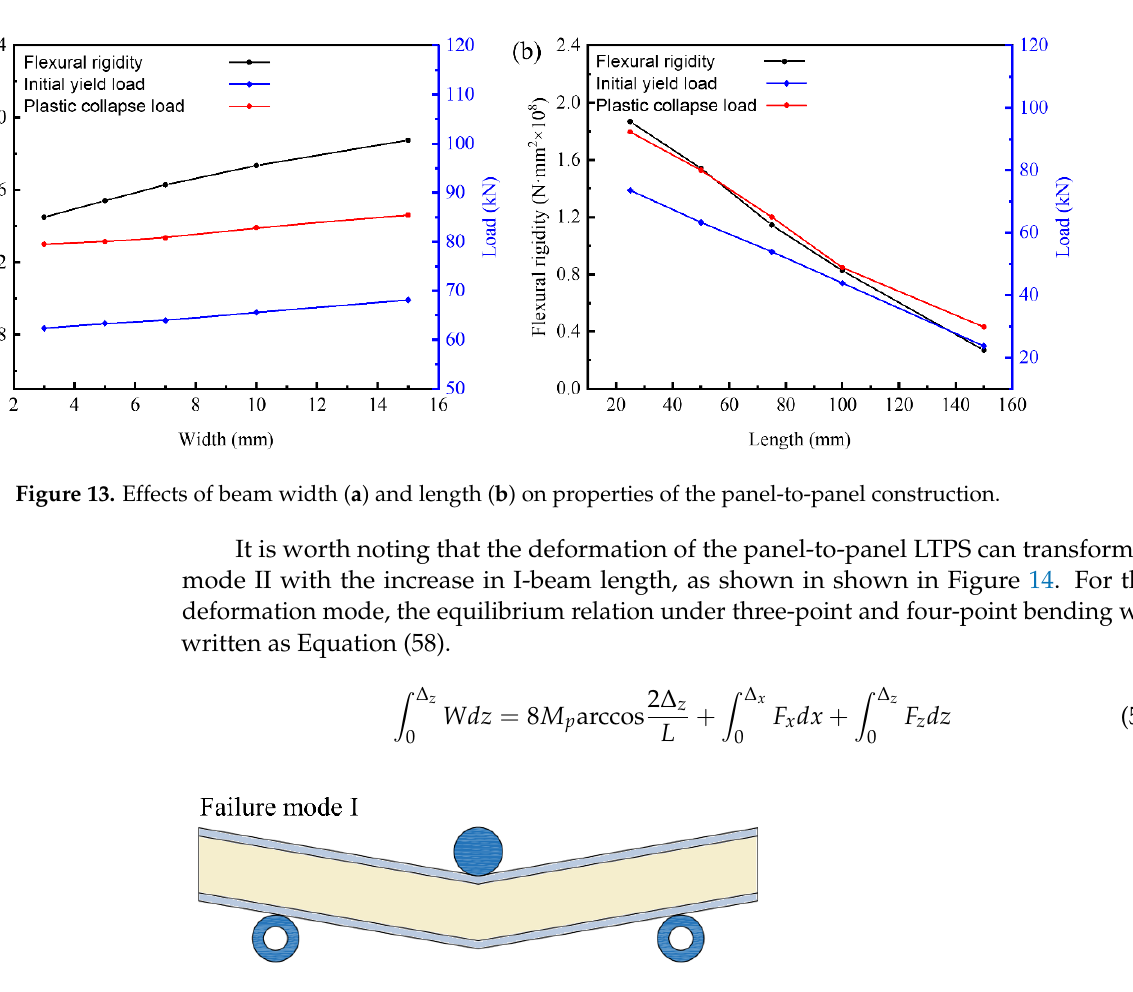
By differentiating Equation (58), the force on the sheet metal under three-point and four-point bending are Equations (59) and (60), respectively.